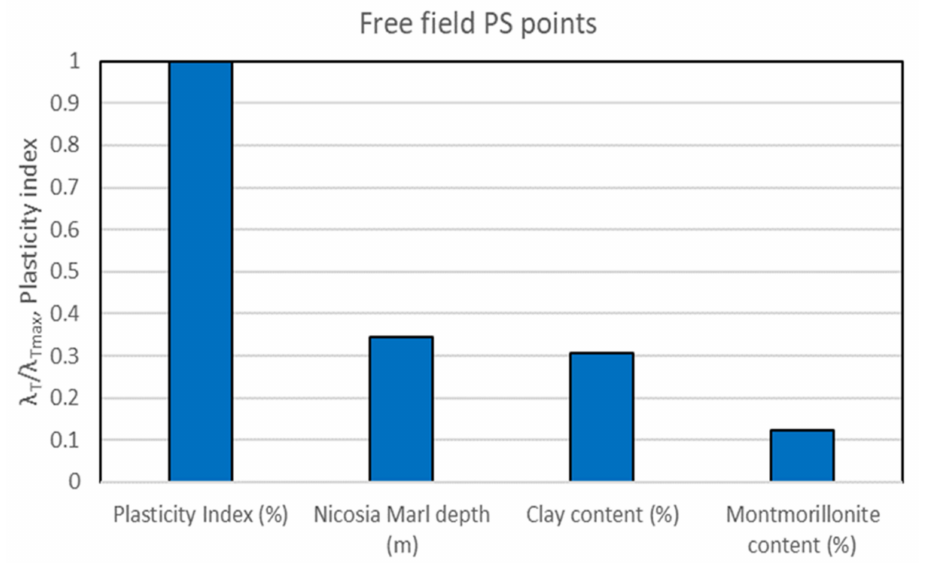
Figure 15. Rank of relative importance of causal variables based on Lasso regression for free field PS